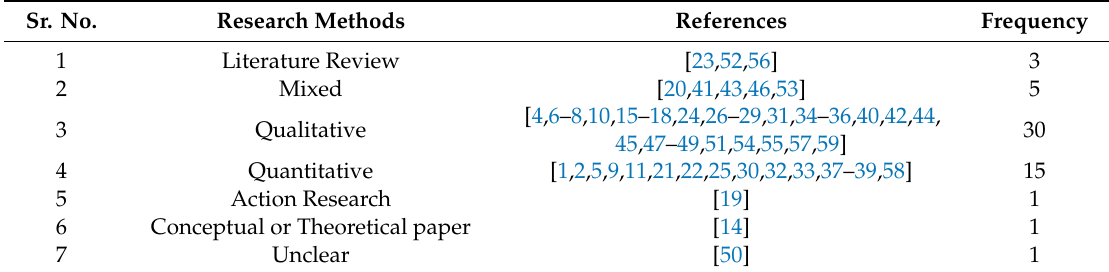
Table 4. Research Methods.